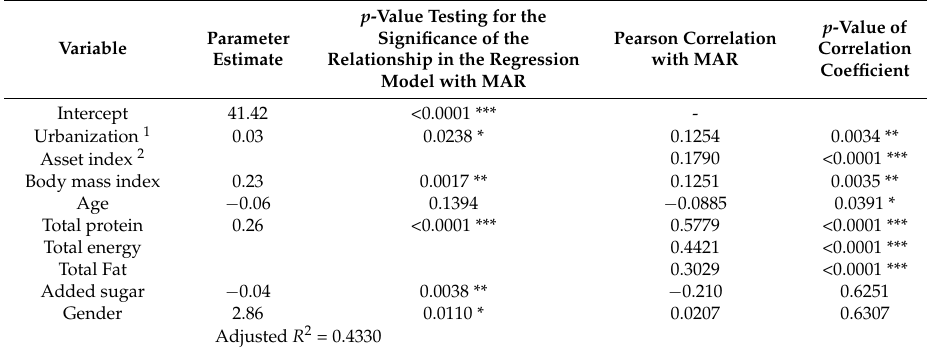
Table 6. Linear regression with mean adequacy ratio (MAR) of the diet as dependent variable for data from the 2009 study. p -Value Testing for the Significance of Variable